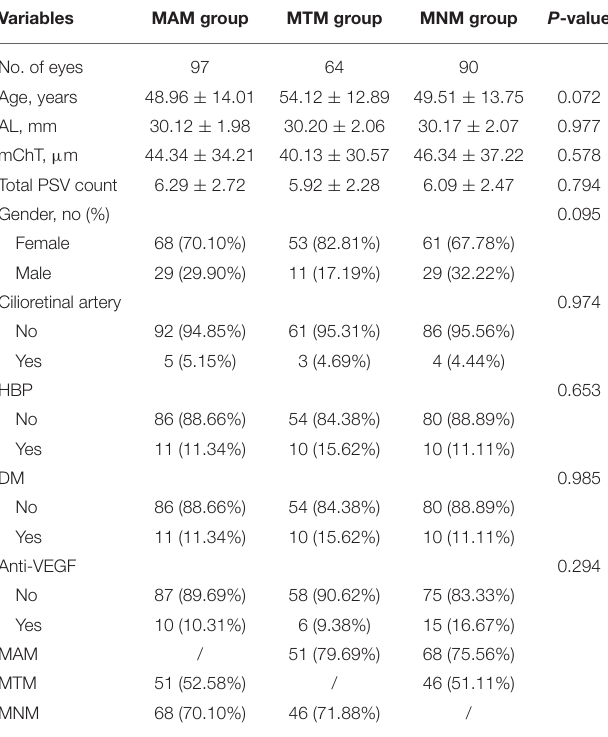
TABLE 2 | Characteristics and comparison between highly myopic eyes and three different types of myopic maculopathy.